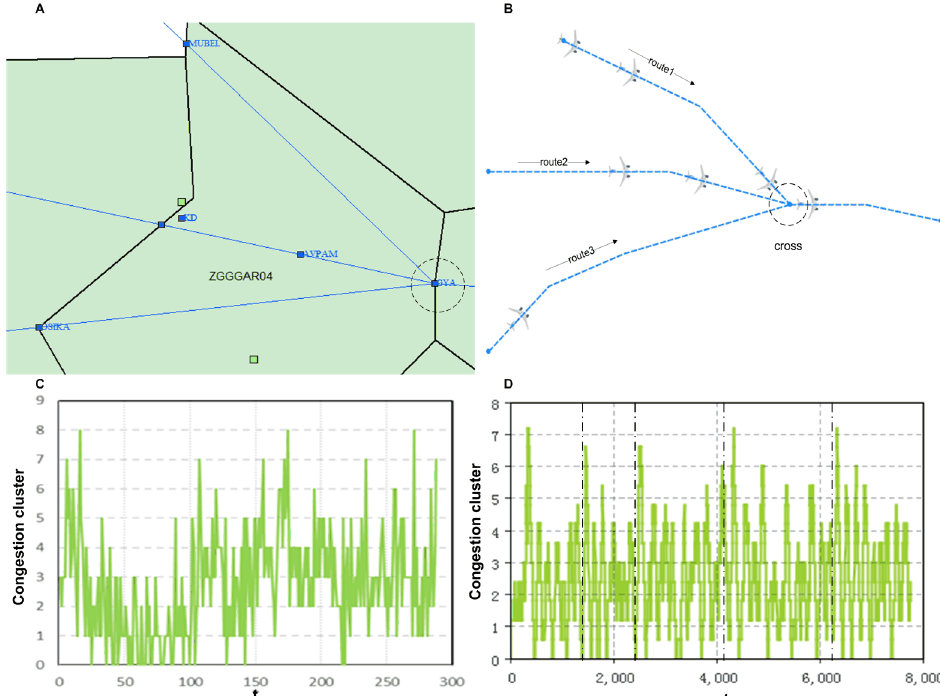
Fig 4. Comparison reality with